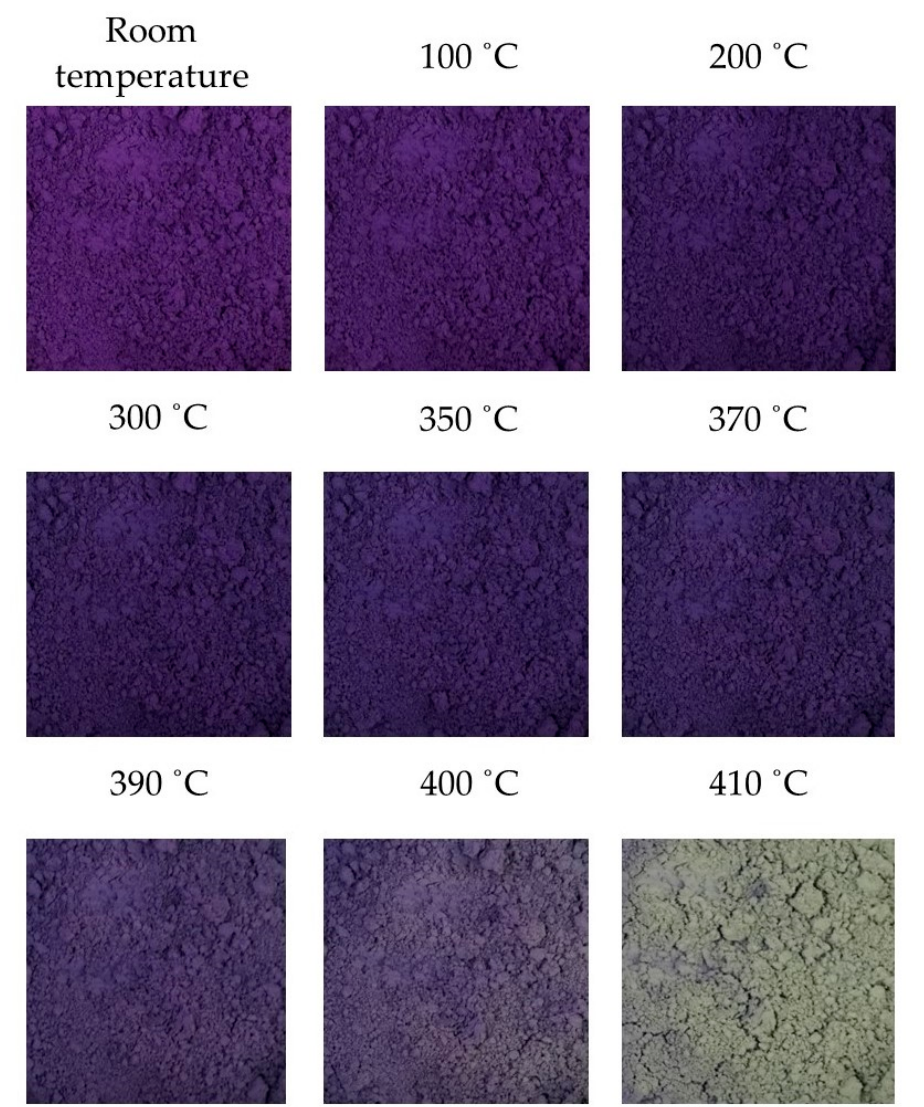
Figure 1. Color changes in the MV pigment with temperatures (Scale: 1000 × 1000